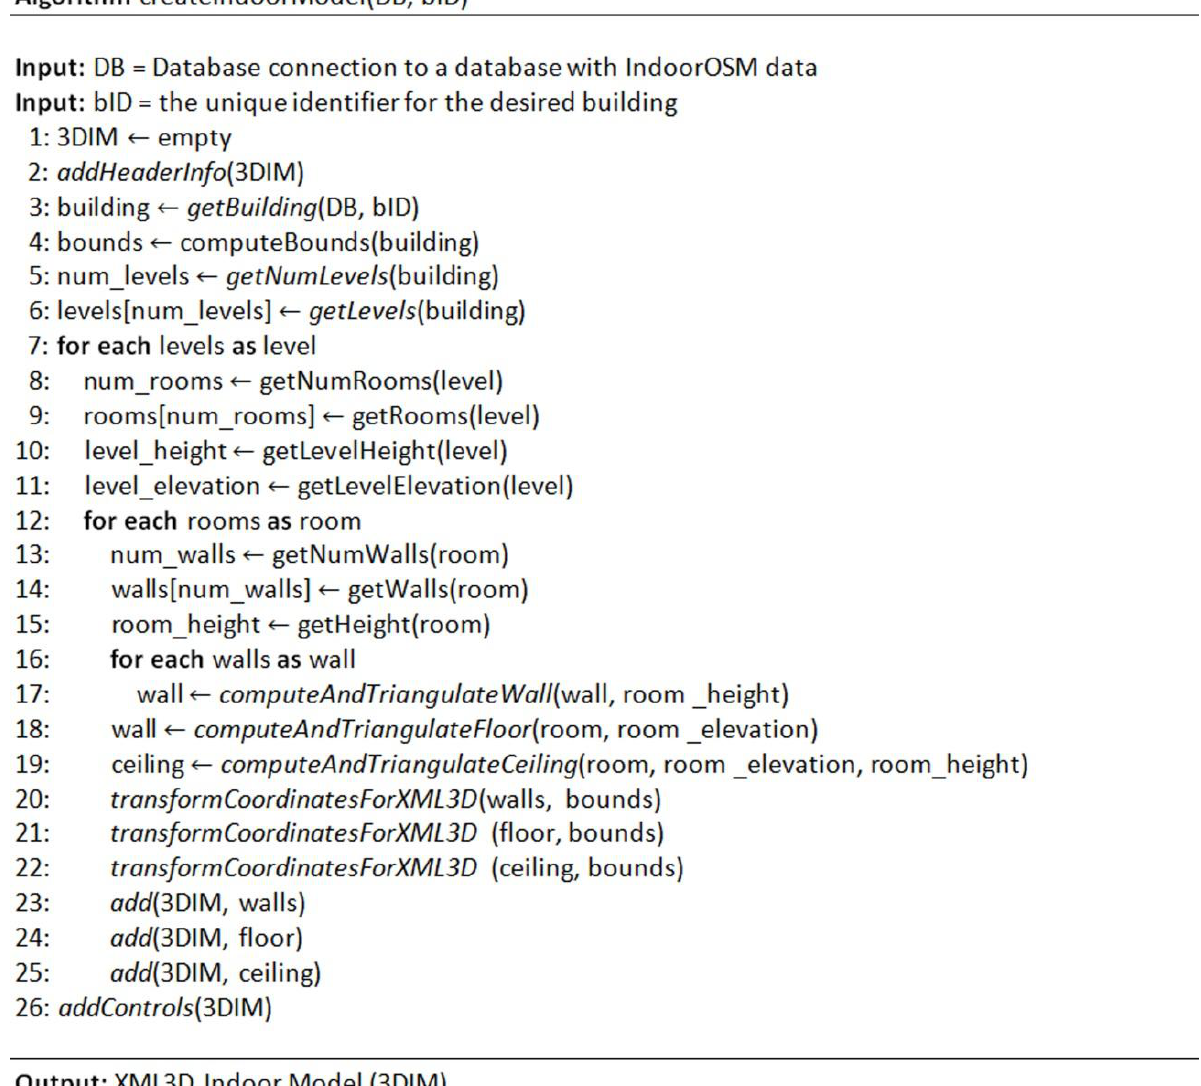
Figure 5. Pseudo-code algorithm for the generation of a XML3D indoor model from IndoorOSM